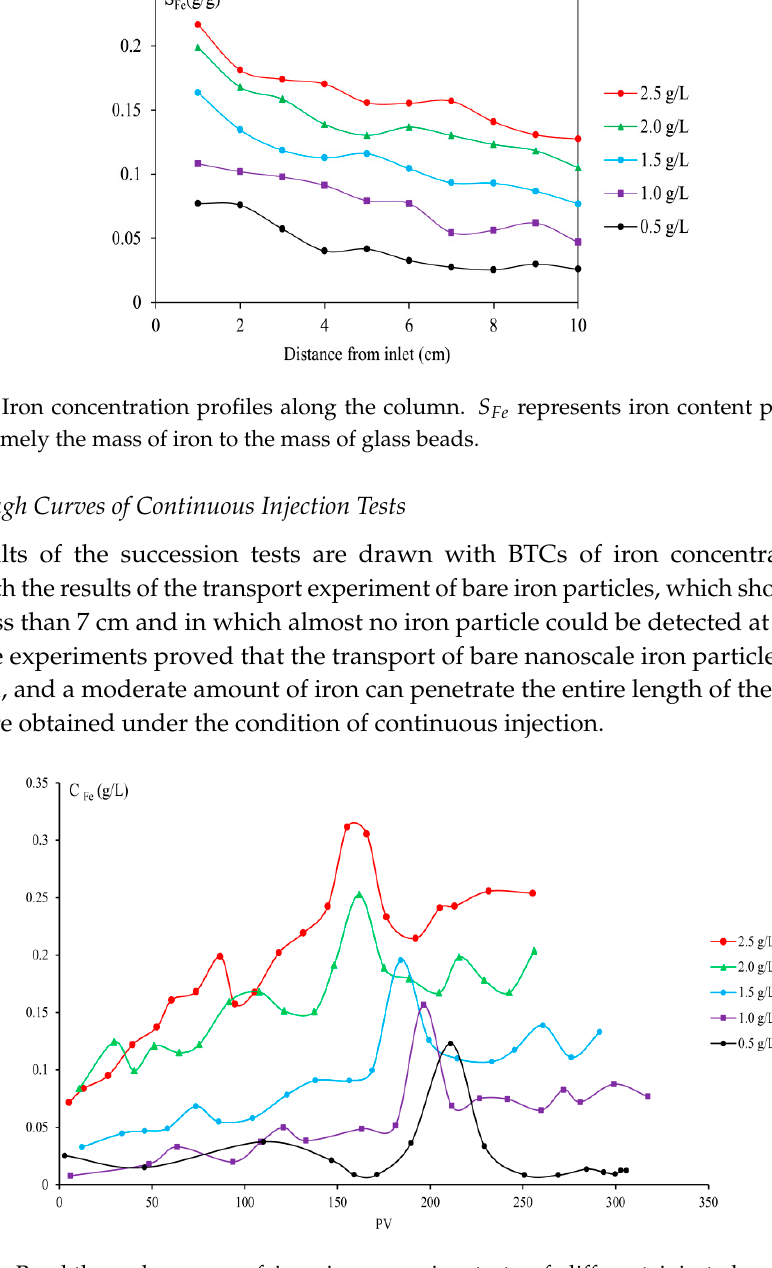
Figure 5. Iron concentration profiles along the column. (cid:1845) (cid:3007)(cid:3032) represents iron content per unit solid matrix, namely the mass of iron to the mass of glass beads.